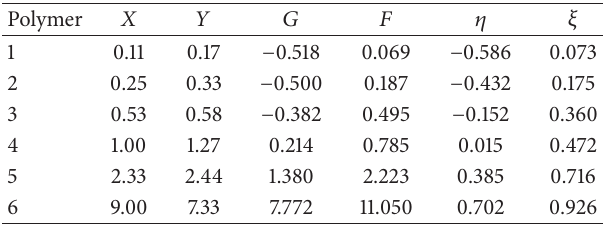
data were reanalyzed using the extended Kelen-T¨ud¨os (EKT)